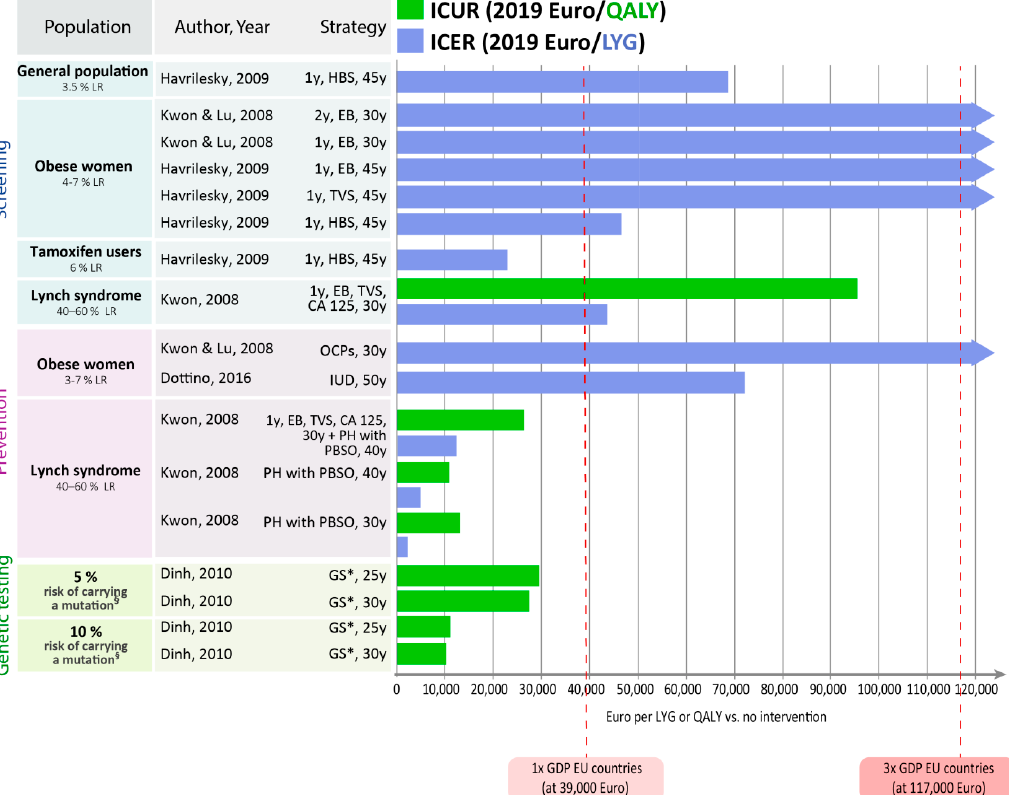
Figure 2. Cost-effectiveness results for each intervention in comparison to no intervention. EB: endometrial biopsy; GS: genetic screening + EB, TVS (plus colonoscopy to early detect colorectal cancer); HBS: hypothetical biomarker panel screening including prolactin (sensitivity and specificity of 0.98, both); IUD: Levonorgestrel intrauterine device; LR: lifetime risk; OCPs: oral contraceptive pills; PBSO: